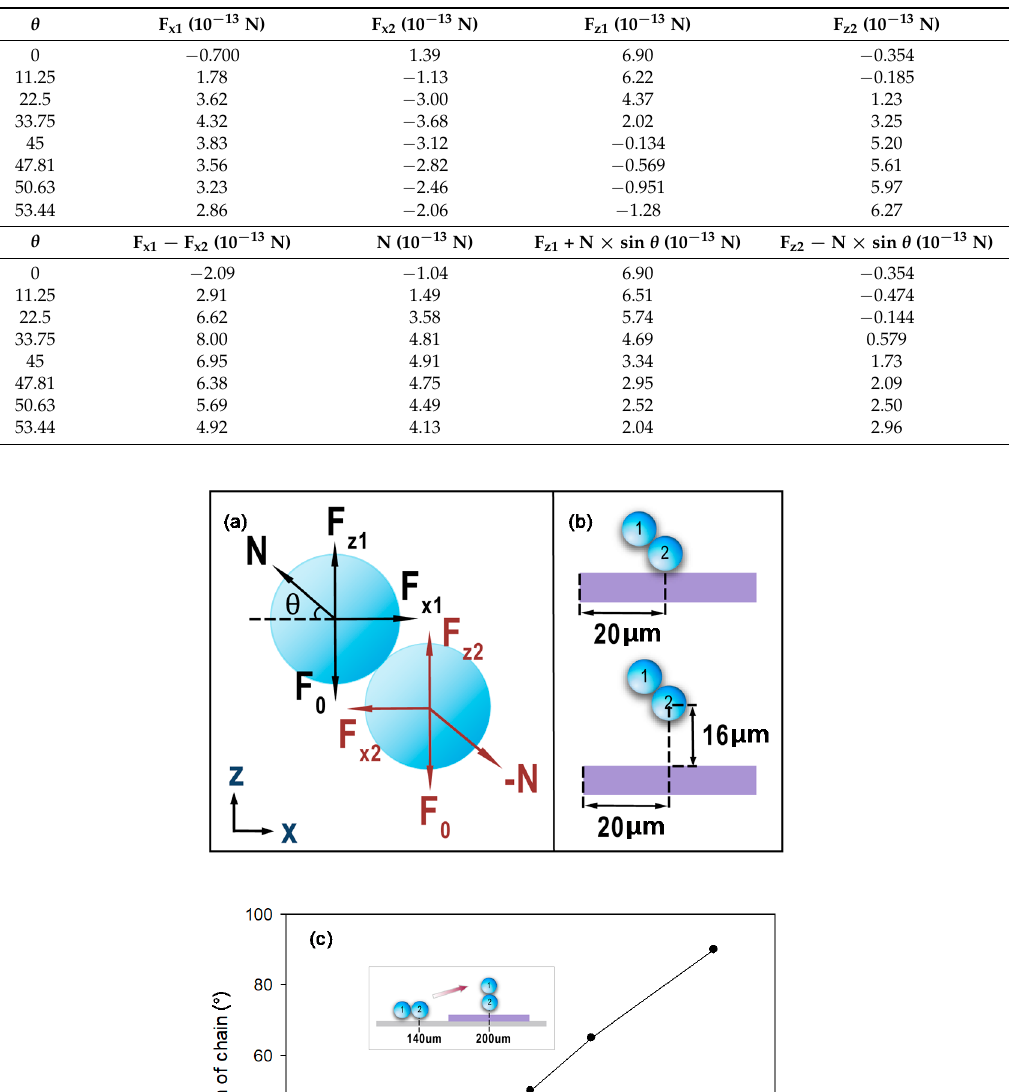
Table 3. Forces on two particles (particle 2 sits atop the electrode 20 µm from the left edge 16 µm above the floor).